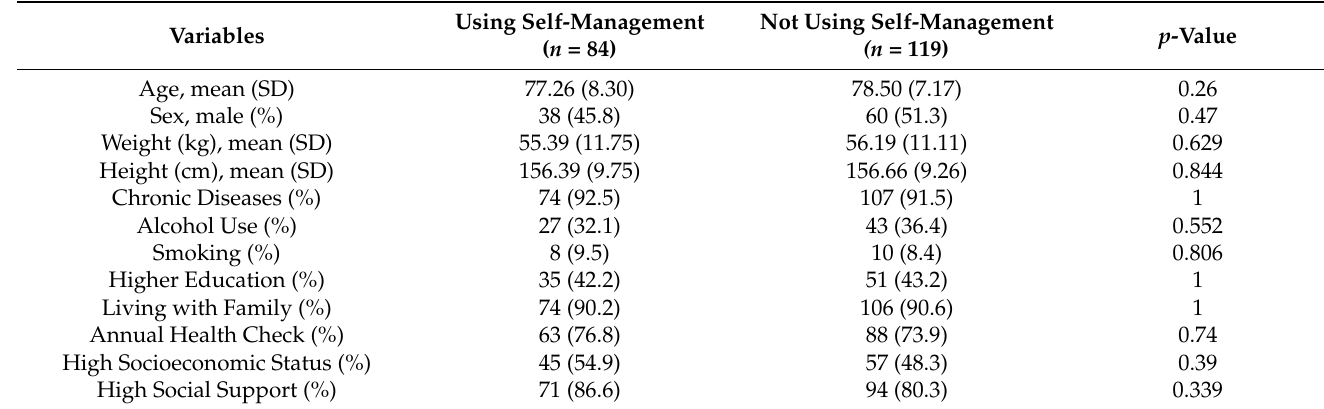
Table 1. Demographic data of participants in the exposure and control groups and the significance level of the comparison between the two groups.